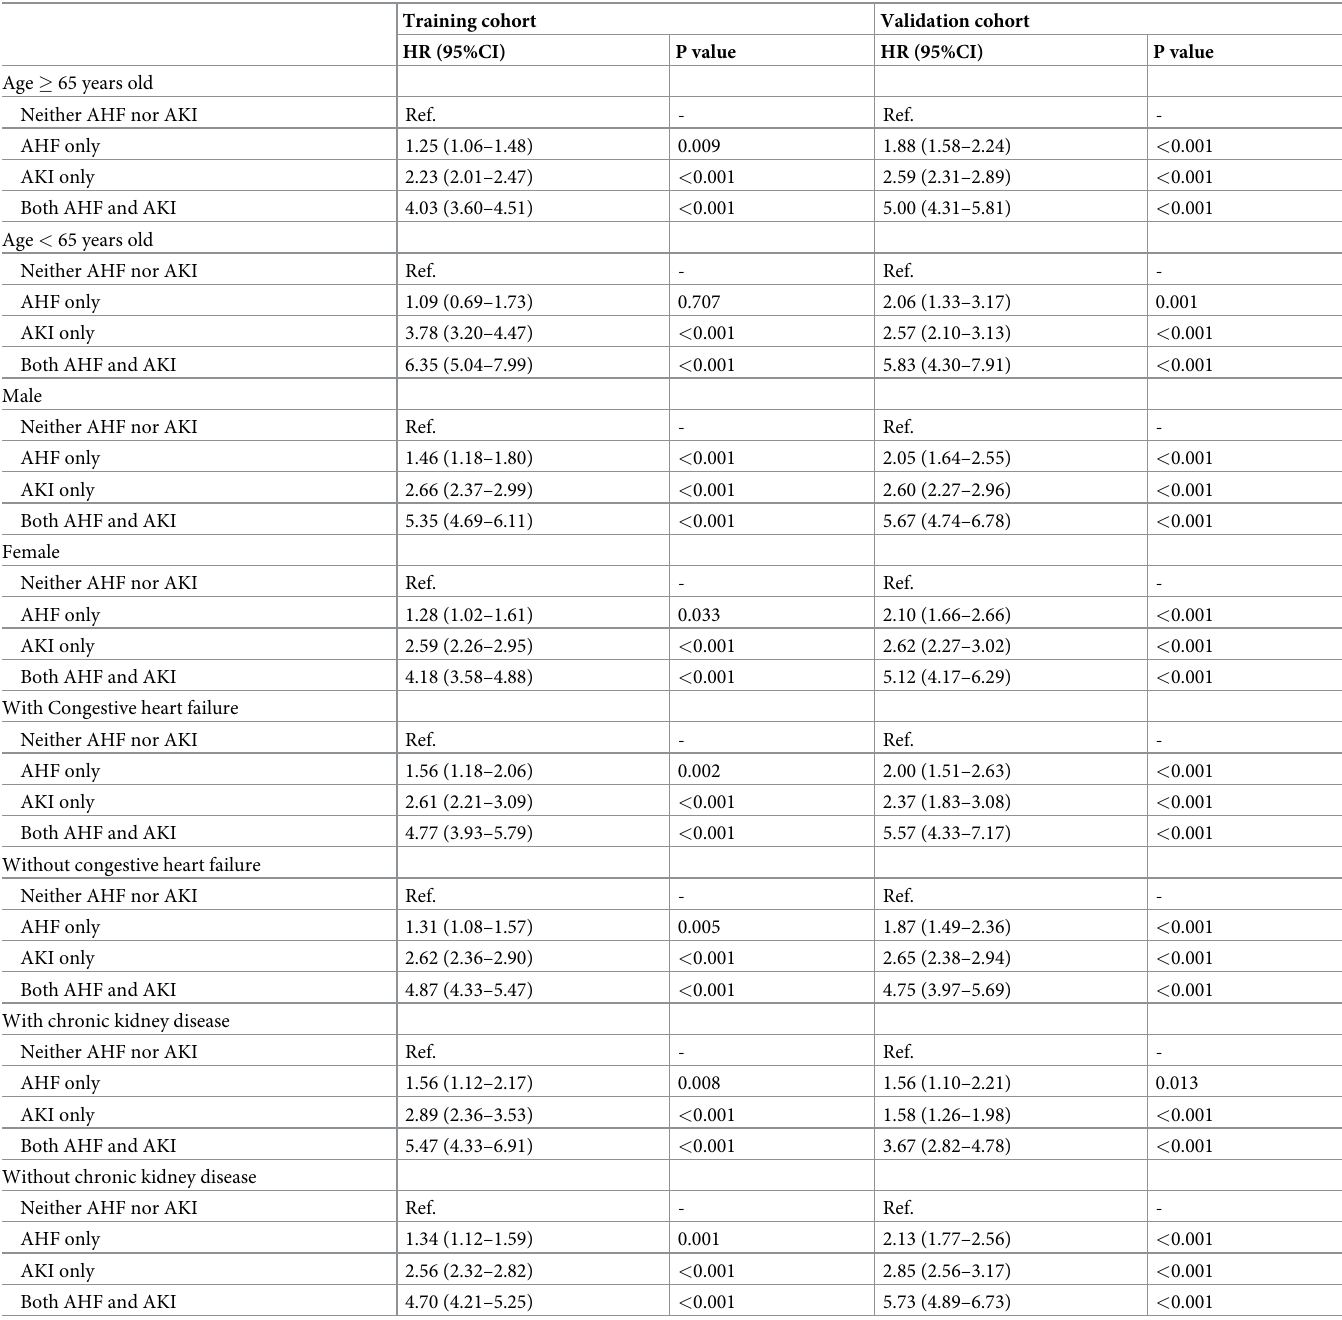
Table 4. Pre-specified subgroup analysis with hazards ratio of in-hospital mortality for patients with